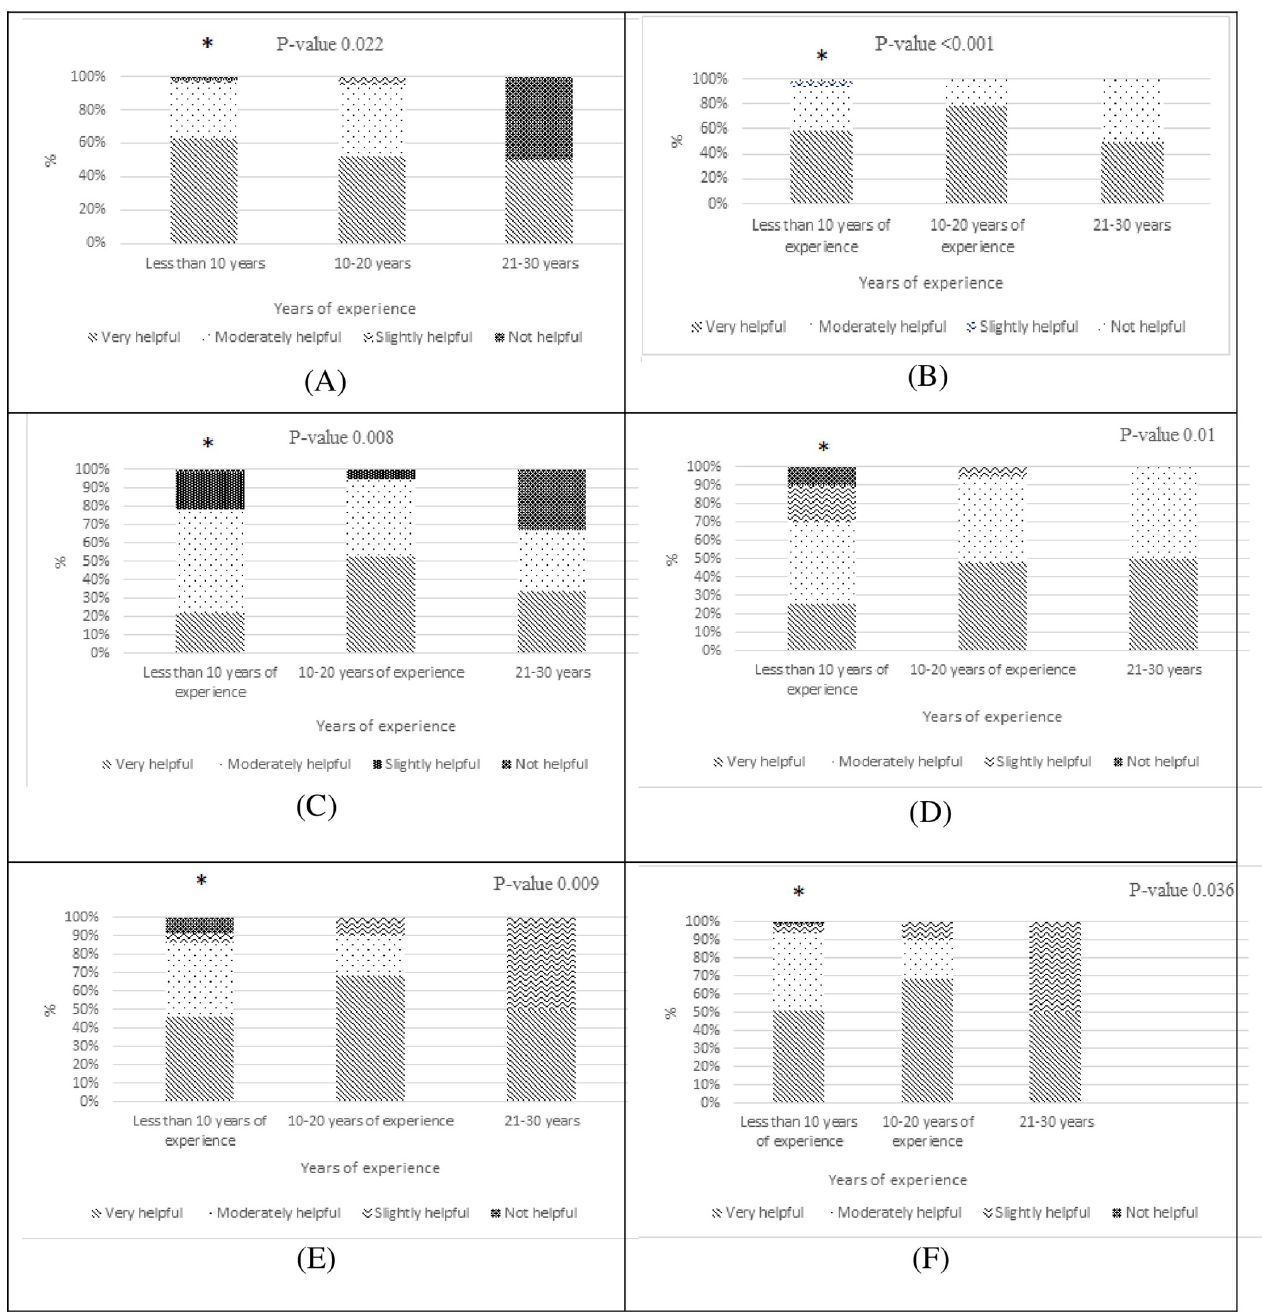
Fig 7. Significant relationship between physician’s years of experience and the following interventions ( � significant p -value < 0.05 compared to more experienced physicians). (A) Advice from ICU senior doctor, (B) Advice from an infectious doctor, (C) Implementation of persuasive ASP, (D) Implementation of restrictive ASP (E) Availability of systematic reports about resistance, (F) Implementation of monitoring systems of used